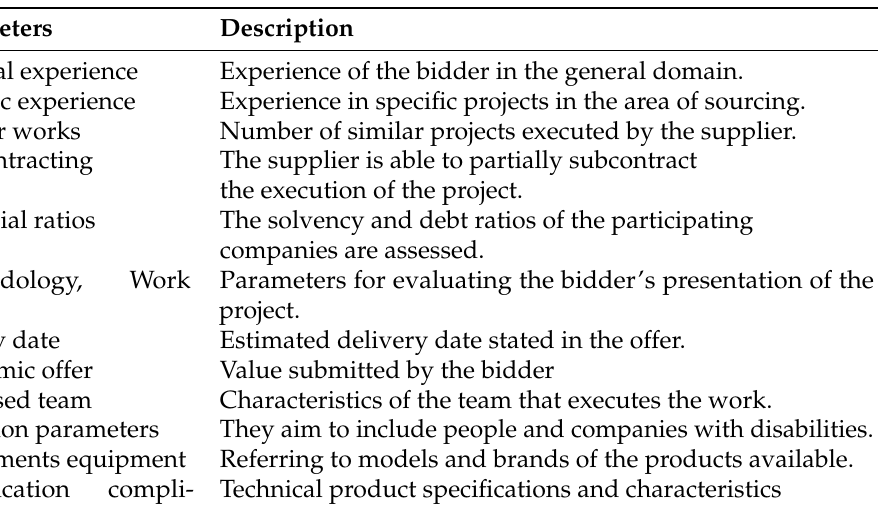
Table 2. Parameters for qualification of an individual process.